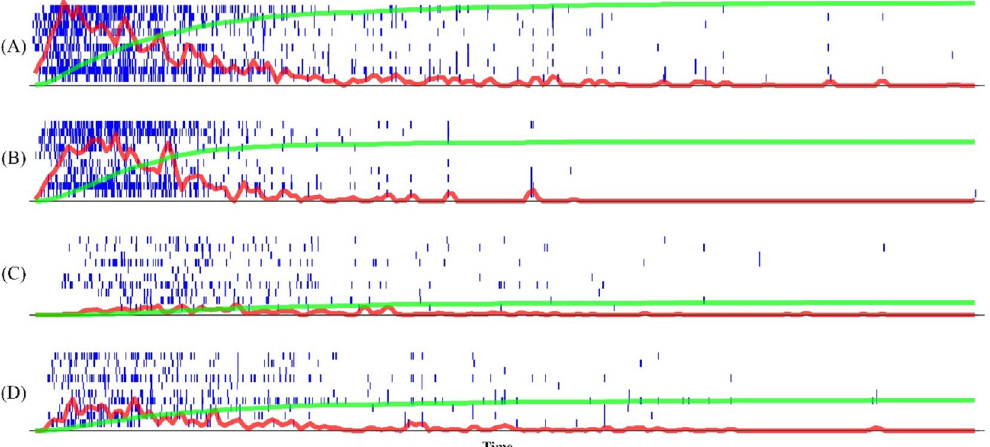
Figure 2. Model raster plot for 10 face-selective neurons. Red curve indicates running average firing rate (AFR) of model neurons. Cumulative AFR is represented by green. ( A ) face without noise; ( B ) face with 20% noise; ( C ) face with 30% noise; ( D ) house without noise. Neurons in all four panels are the same STDP face trained neurons and only the input image is different.